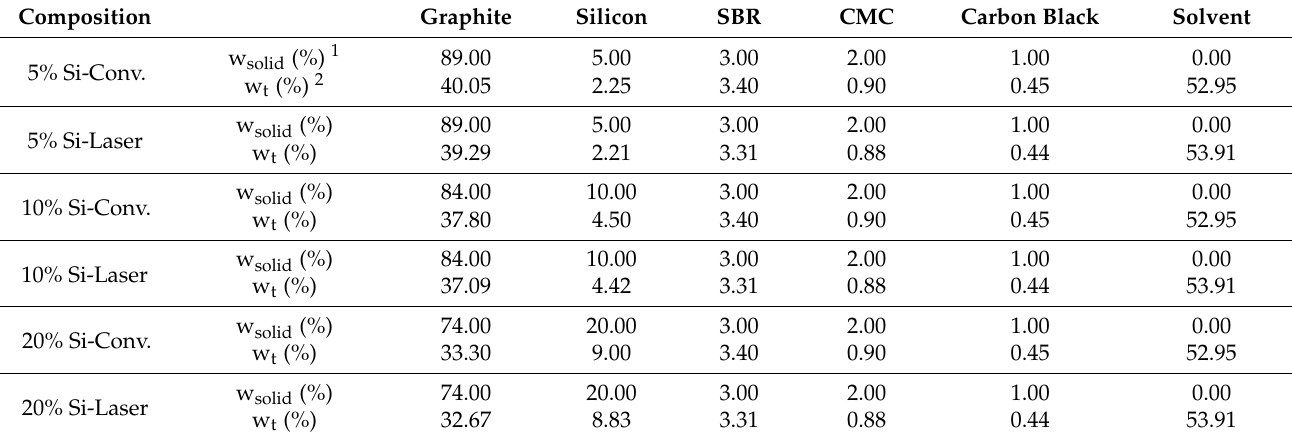
Table 1. Slurry compositions for convection and laser drying of silicon–graphite